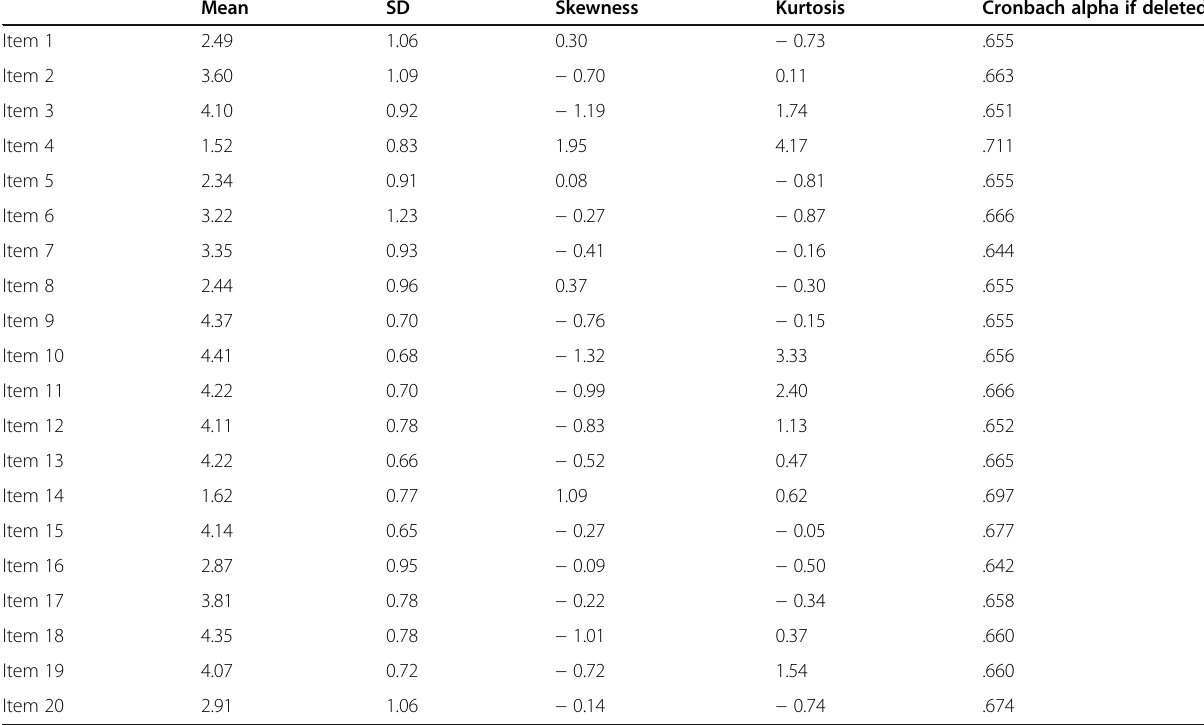
Table 1 Means, standard deviation (SD), kurtosis, skewness and exploratory factor loadings ( n = 162)